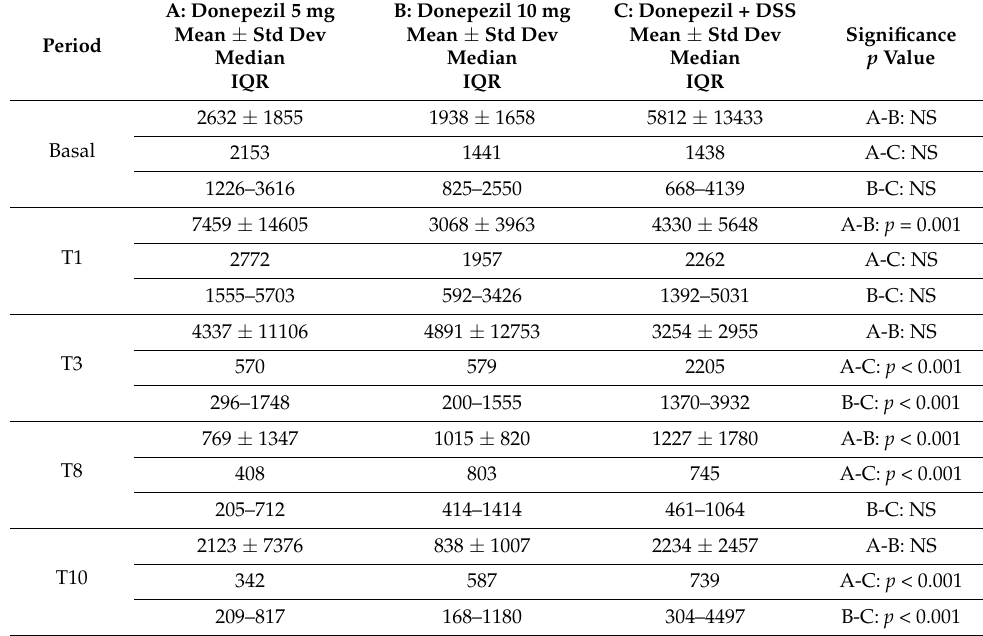
Figure 11. Electrogastrography power after a single intragastric dose of 5 mg of donepezil (group A). Outliers omitted. Y axis: natural log scale.